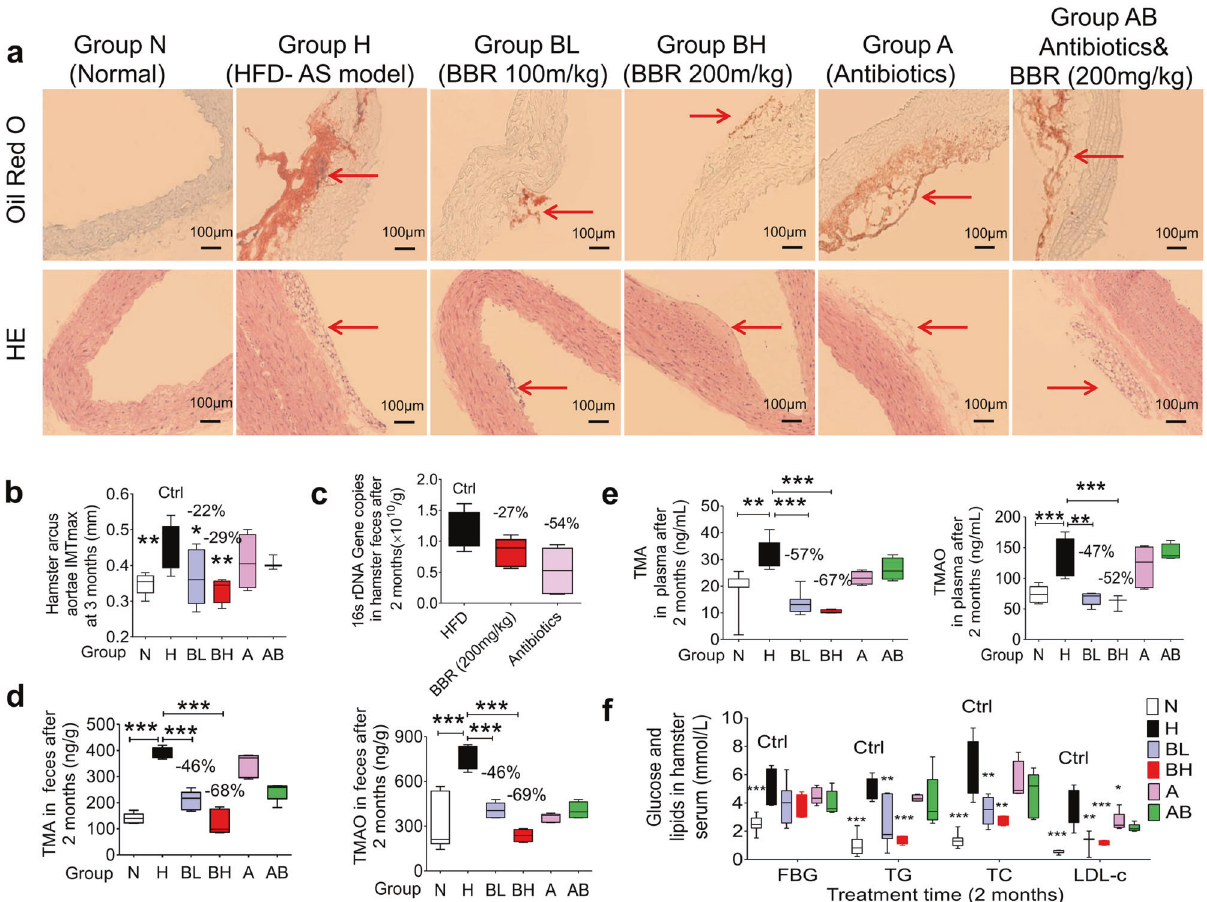
n = 7; Group BL, the low-dosage BBR group (oral, 100 mg/kg/d), n = 7; Group BH, the high-dosage BBR group (oral, 200 mg/kg/d), n = 4; Group A, the group treated with antibiotics (oral, terramycin 300 mg/kg/d, erythromycin 300 mg/kg/d and cefadroxil 100 mg/kg/d, 3 months), n = 5; Group AB, the group treated with BBR and the combination of antibiotics (oral, terramycin 300 mg/kg/d, erythromycin 300 mg/kg/d, cefadroxil 100 mg/kg/d, and BBR 200 mg/kg/d; 3 months), n = 5. Red arrows: the location of plaques. b The maximum intima-media thickness (IMT max ) measurement of arcus aortae in hamsters showed that BBR signi fi cantly alleviated the severity of atherosclerosis after 3 months treatment (* P < 0.05, ** P < 0.01). c 16 s rDNA Gene copies in hamster faeces at the point of two months. The number of colonies was decreased after the treatment with combination of antibiotics for two months ( − 54%) or the treatment with BBR ( − 27%, 200 mg/kg), in comparison with the HFD model group. d BBR signi fi cantly inhibited the production of TMA and TMAO in faeces, and the effects were weakened after intervention with antibiotics (2 months, *** P < 0.001). e Oral administration of BBR signi fi cantly lowered the levels of TMA and TMAO in plasma after 2 months therapy (** P < 0.01, *** P < 0.001) . f The levels of FBG, TG, TC and LDL-C in serum were signi fi cantly lowered by oral administration of BBR